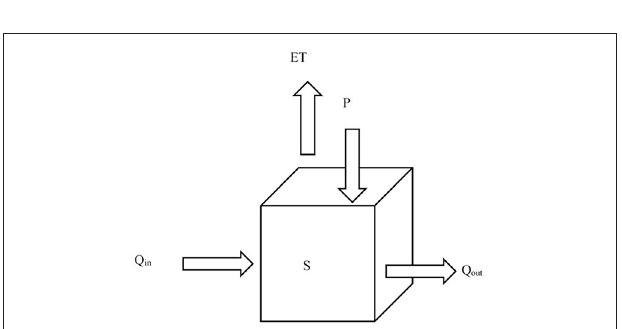
a typical year, using a monthly time step along with the following